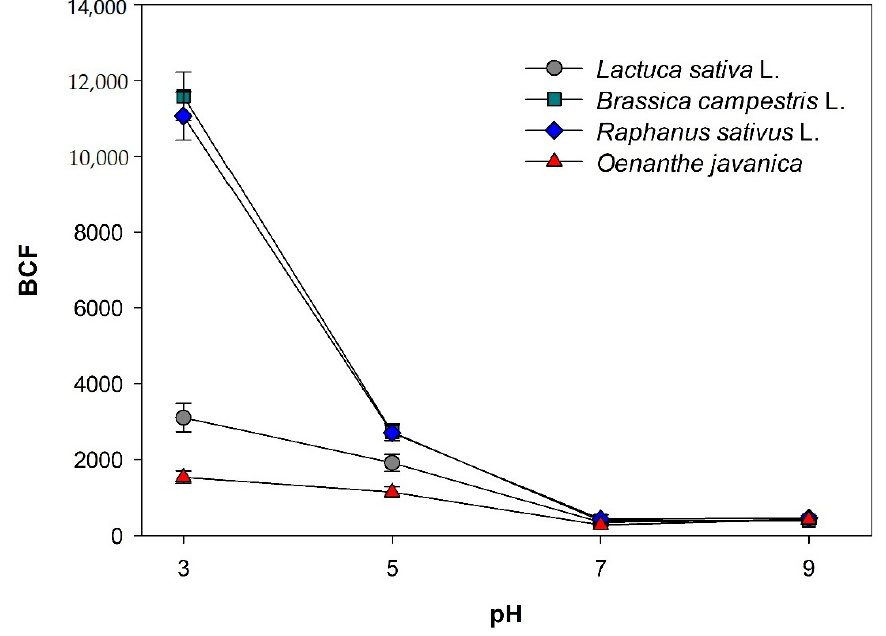
Figure 3. Uranium bioconcentration factors of four different plant species in artificially contaminated solutions with four different pH values after 72 h treatment.